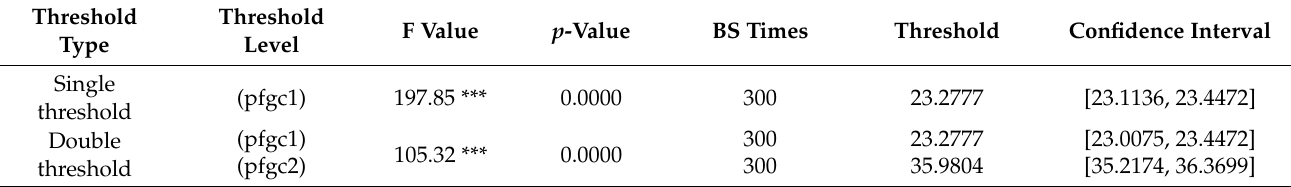
Table 5. Test results of the threshold effect.